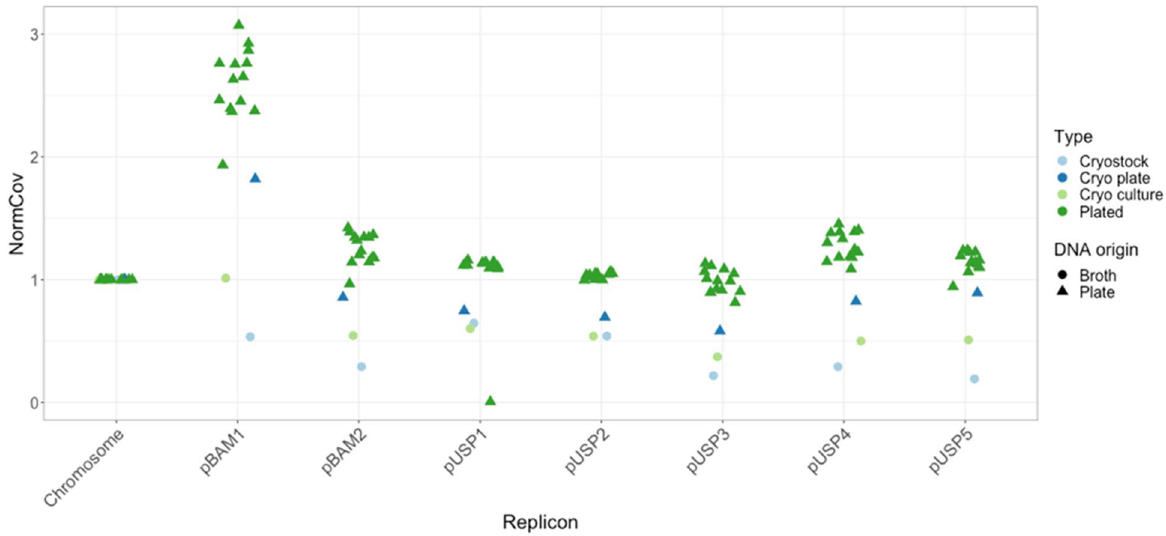
Figure 5. Coverage in 1000 bp windows of replicons normalized to chromosome coverage (NormCov). A NormCov of 1 indicates a single copy per chromosome of a replicon. A NormCov above 1 indicates that there are more copies of a given plasmid than the chromosome per cell. Points have been slightly jittered horizontally to improve visualization of